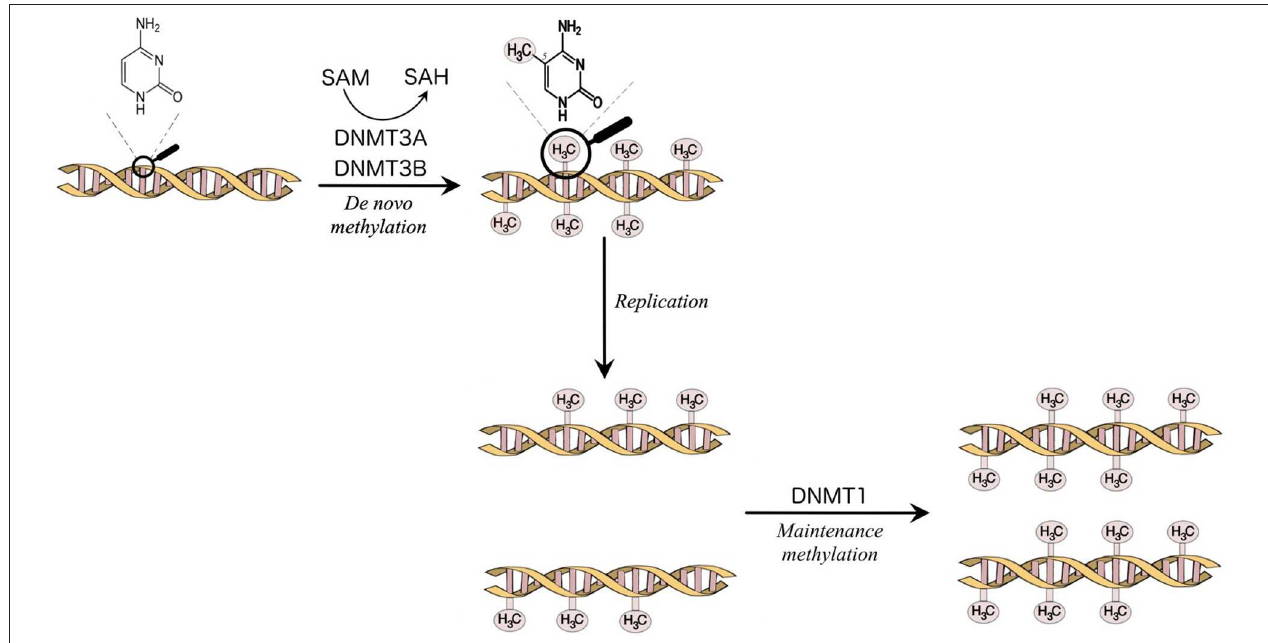
FIGURE 1 | Methylation of the carbon 5 position of cytosine is catalyzed by DNA methyltransferases (DNMTs). S-Adenosyl methionine (SAM) acts as a methyl donor in the methylation reaction and is converted to S-Adenosylhomocysteine (SAH). DNMT3A and DNMT3B are responsible for the establishment of new DNA methylation patterns. DNMT1 mediates the maintenance of established patterns of methylation after replication (